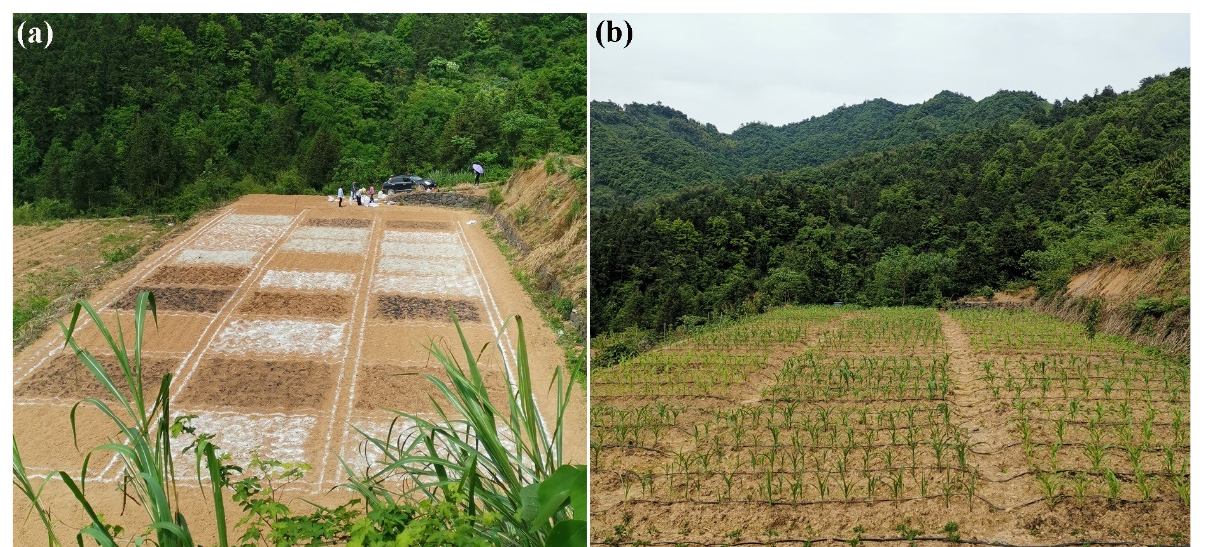
TMF: Tuzangjin microbial fertilizer; CMA: carbonergic microbial agent; SMF: seaweed microbial fertilizer; SM: sheep manure; CCF: chemical compound fertilizer; OMC: organic matter content; MS: microbe content.